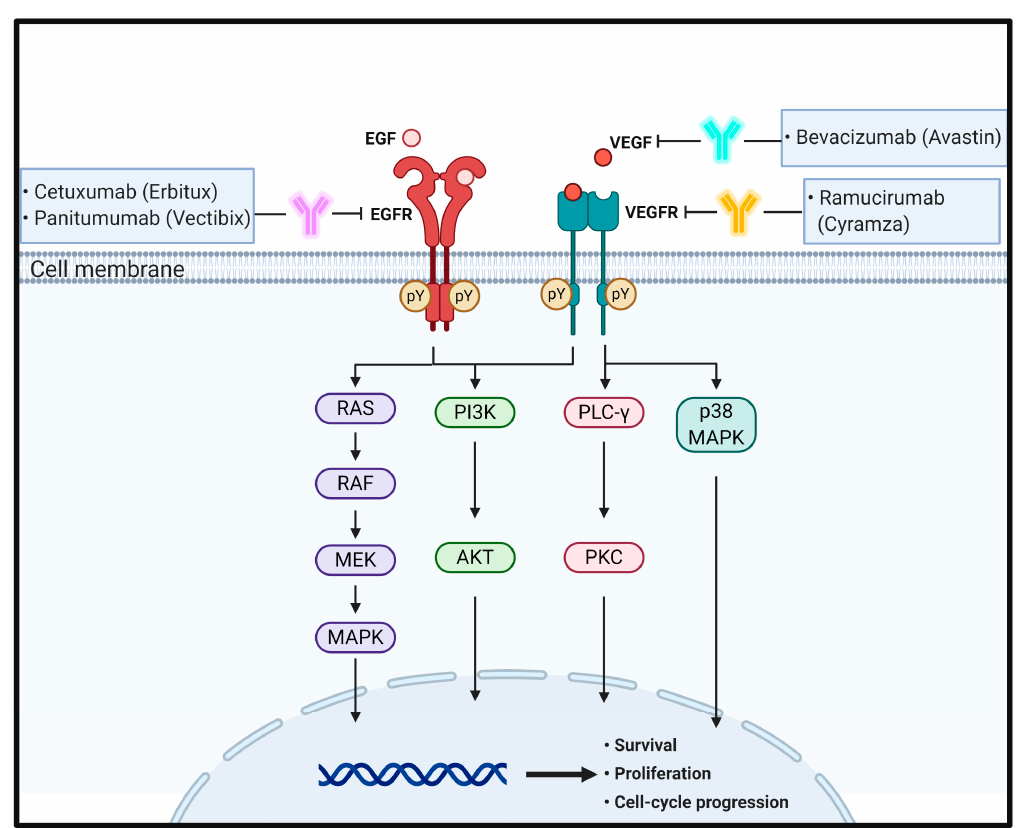
Figure 1. Schematic representation of the physiological roles and signaling pathways of EGF and VEGF and their cognate receptors and the effect of antibodies targeting these signaling molecules on CRC progression and metastasis. pY means phosphotyrosine residues.